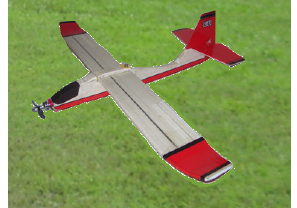
Figure 1. An example of fixed-wing UAV